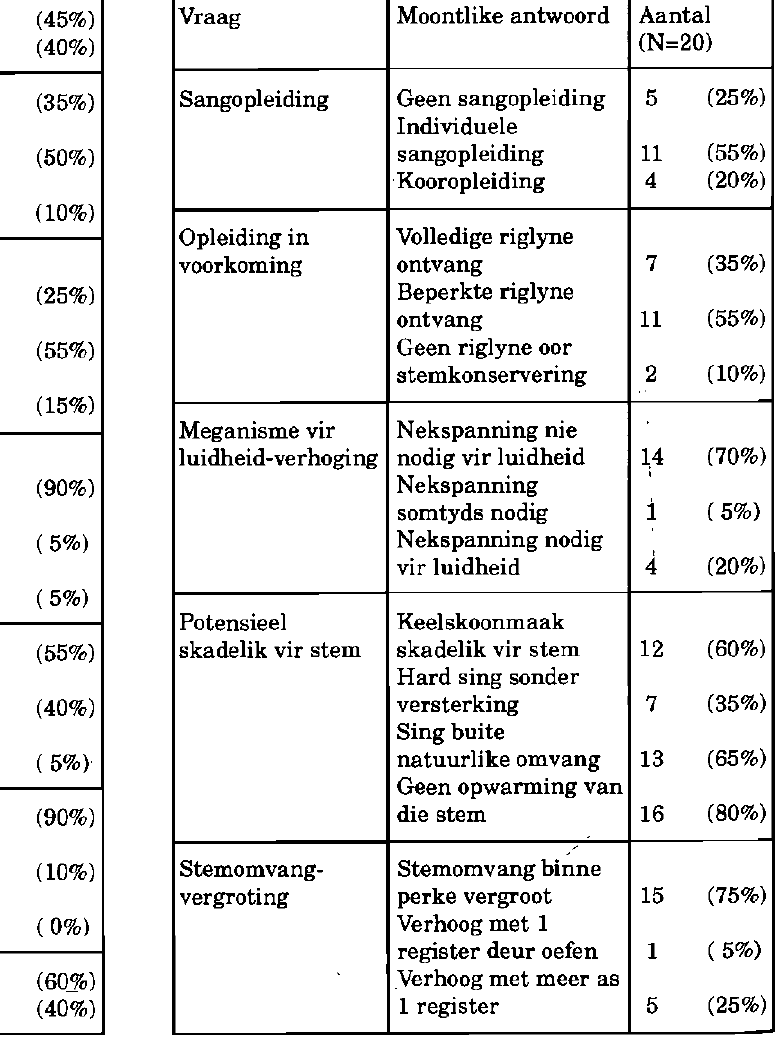
TABEL 10: Kennis van stemprobleme by sangers